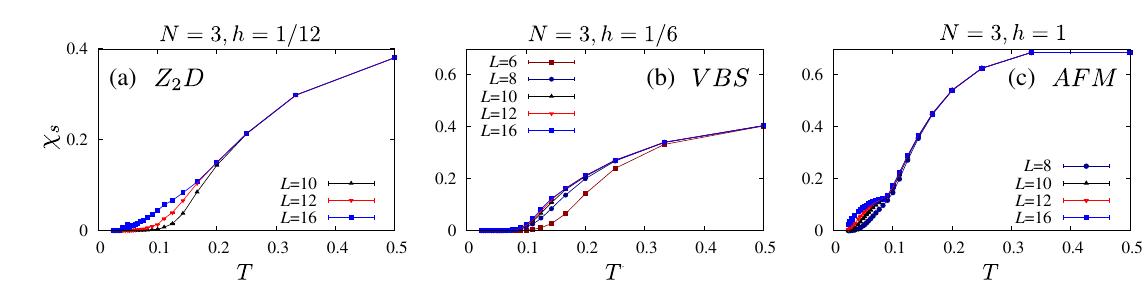
FIG. 16. Uniform spin susceptibility in the Z 2 D, VBS, and AFM